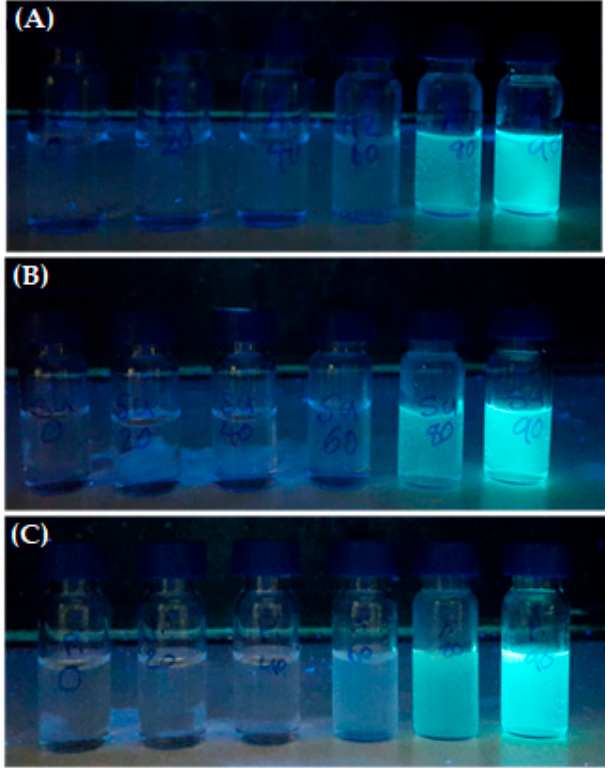
Figure 1. Luminescence properties: photographic images of ( A ) TPE-Az ( B ) TPE-Su ( C ) TPE-Pi in THF-water solvent mixtures with f w values of 0%, 20%, 40%, 60%, 80% and 90% respectively, irradiated at 365 nm.